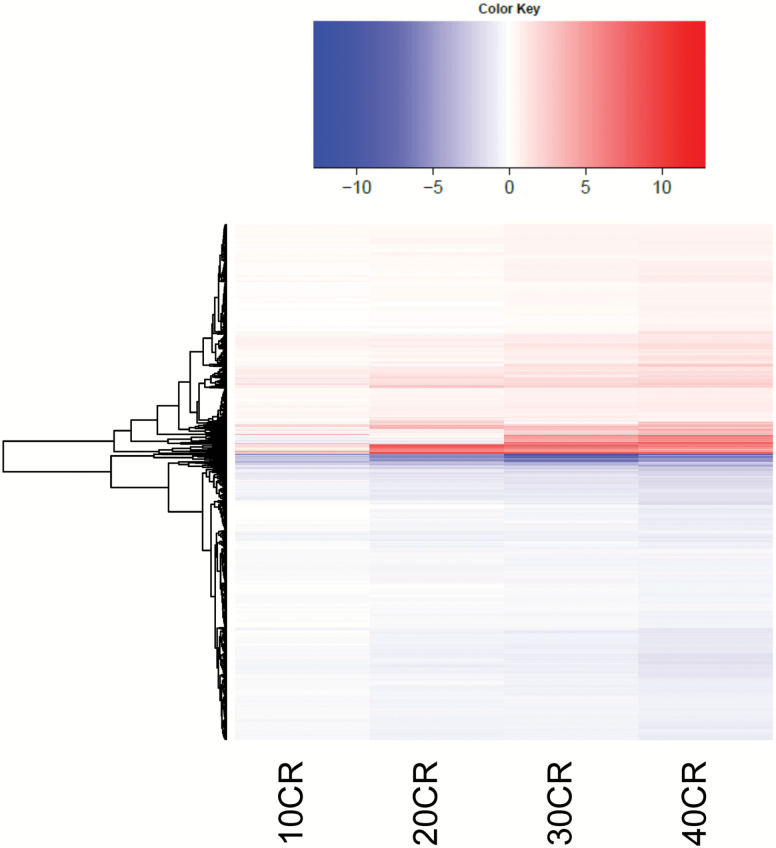
Differentially expressed genes (DEGs) at each level of restriction relative to 12 h ad libitum (AL). The heat map represents the 3435 genes that were significantly expressed relative to 12AL. Red indicates a positive log2 fold change (log FC) and blue a negative log FC. 10CR, 20CR, 30CR, and 40CR refer to 10, 20, 30, and 40% restriction.